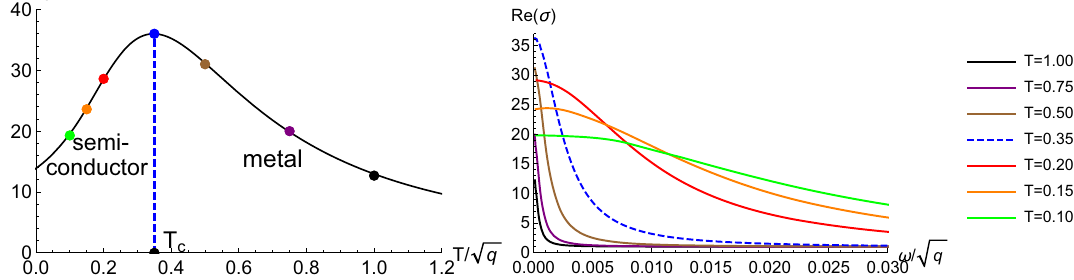
Fig. 5 Left: we have set γ = 1 / 3 . 05 and the transition temperature T c is 0.35. Right: the real part of the AC conductivity as the function of ω